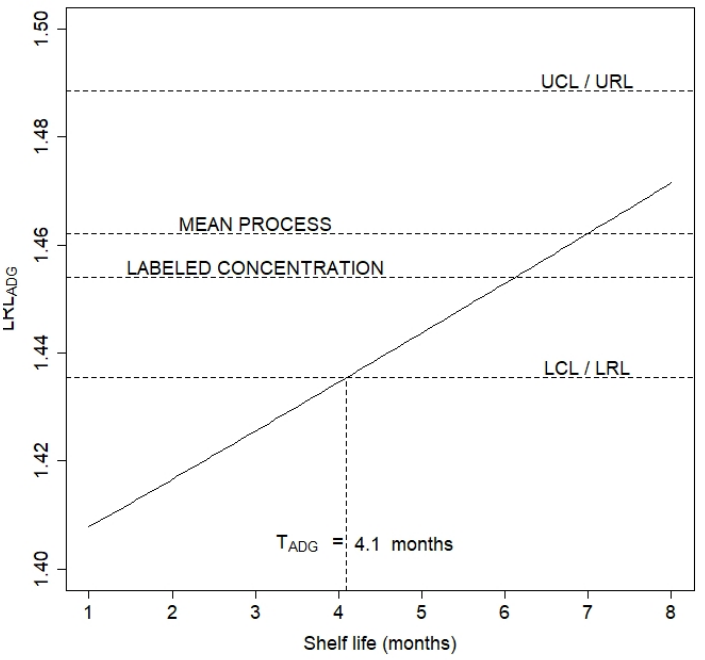
Figure 3. Lower release limit versus expiry time (TE).